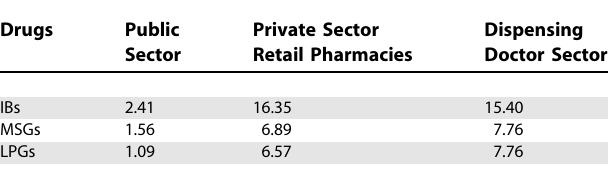
Table 2. Median MPRs of IBs, MSGs, and LPGs in Public Table 1. Distribution and Number of Facilities for Sampling Plan